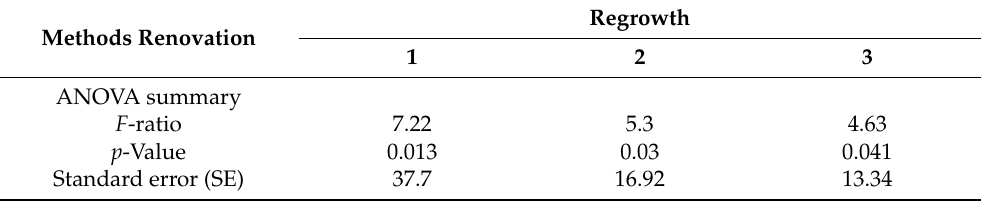
Table 4. ANOVA summary of the average dry biomass weight by grassland for 2014–2016. Methods